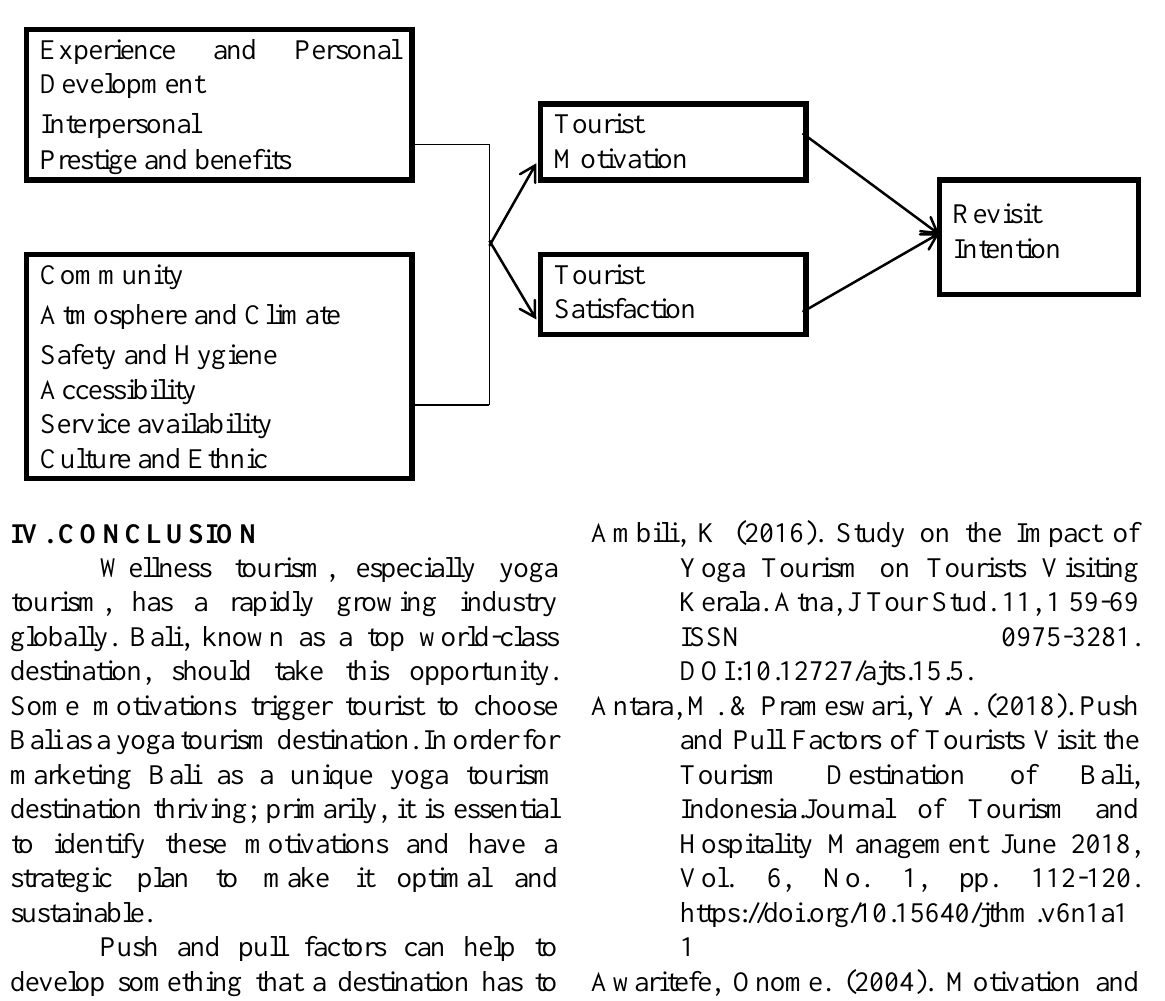
Figure 4. Conceptual